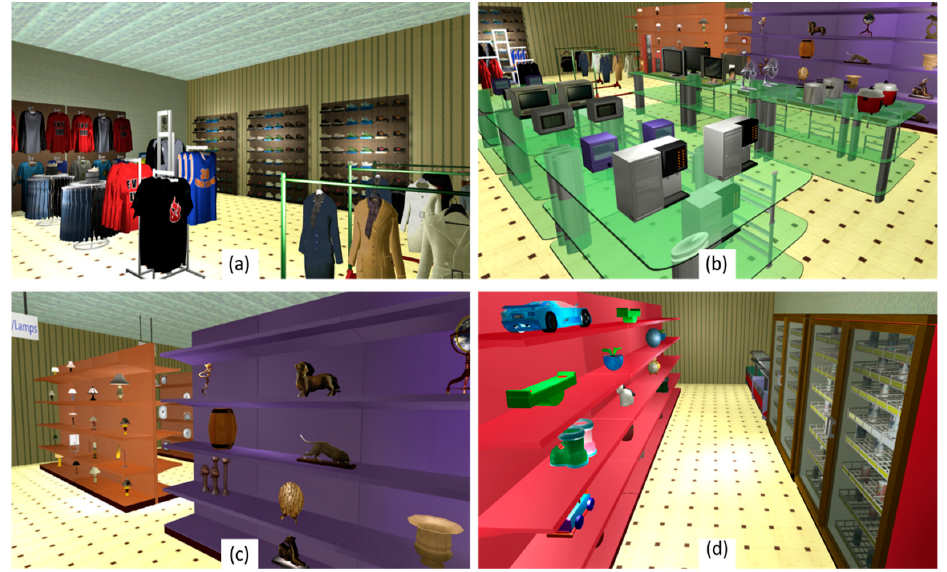
Figure 1. Prototype of the 3D virtual retail store: ( a ) clothes, shoes, and sportswear; ( b ) home appli- ances and 3D commodities; ( c ) lamps, artwork, and clocks; ( d ) children’s toys, drinks, and frozen food.